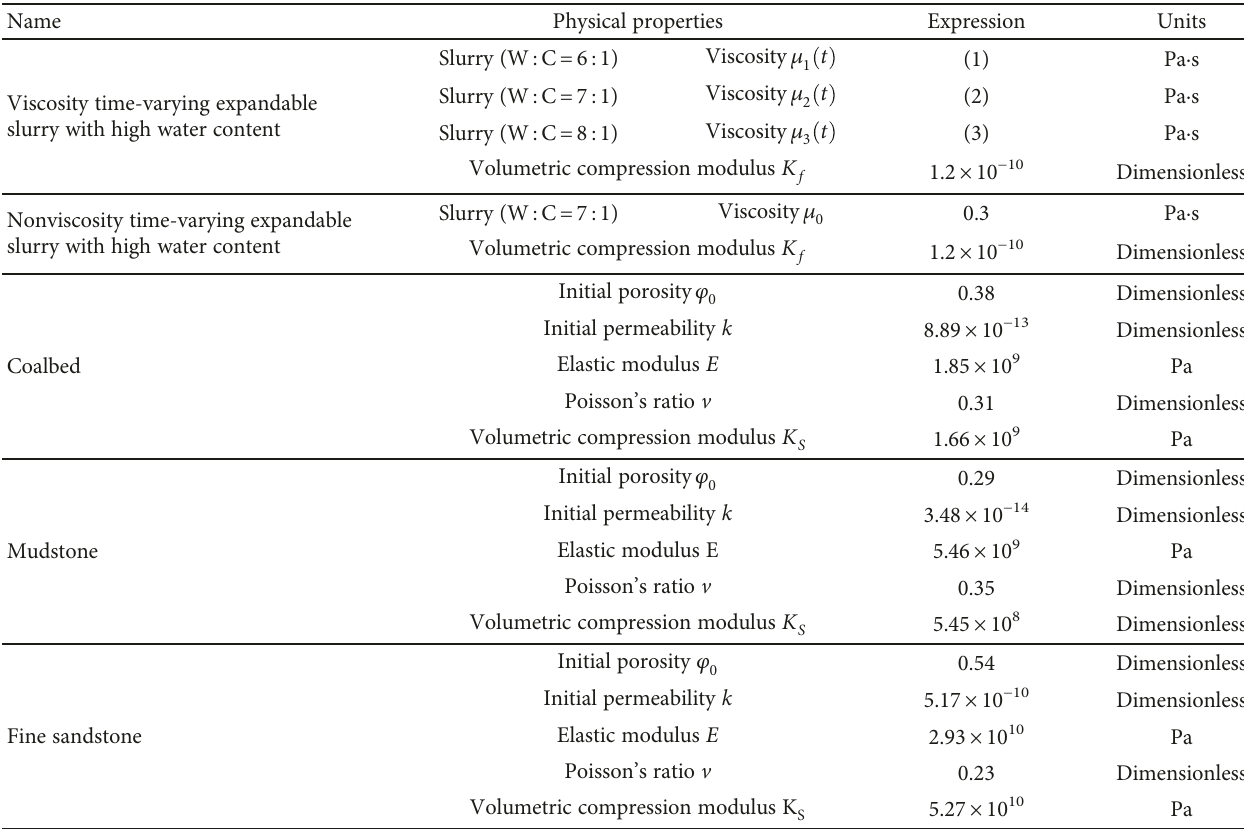
Table 3: Parameters of di ff erent slurries and the